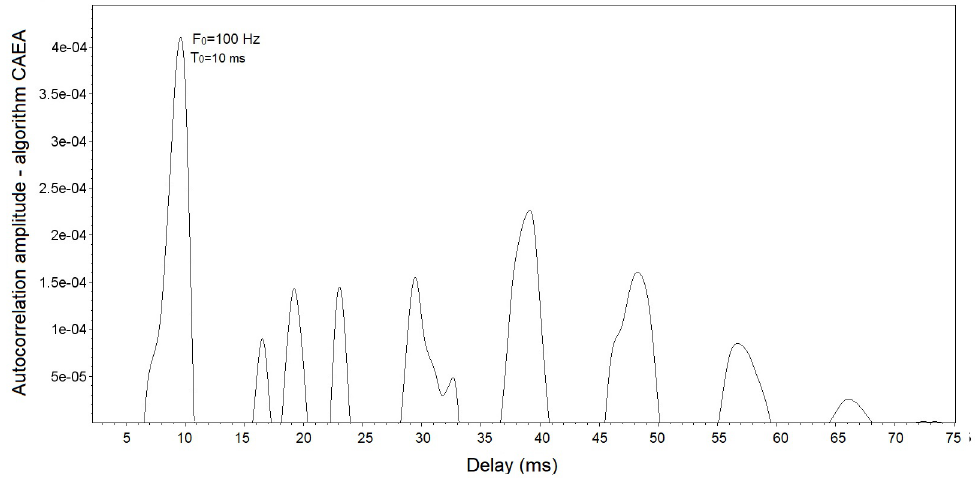
Figure 13. Results of the CAEA algorithm (autocorrelation method) with a fundamental frequency in 100